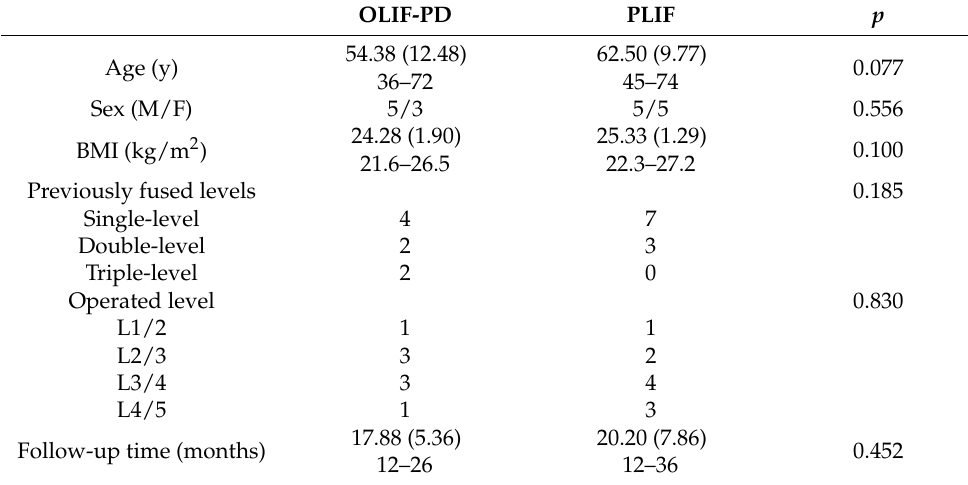
Table 1. Comparison of baseline data of two